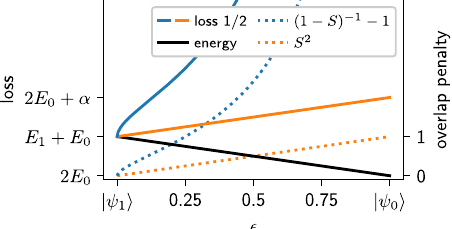
Fig. 6 | Sketch ofthe loss function. This fi gure illustrates the behavior of our loss functionforatwo-statesystem.Thegroundstateiskept fi xedandthesecondstate is considered to be a linear combination of the ground state and fi rst excited state (Eq. (9)). The scales are to be understood in arbitrary units, as they depend on the choice of hyperparameters and the energies of the system under